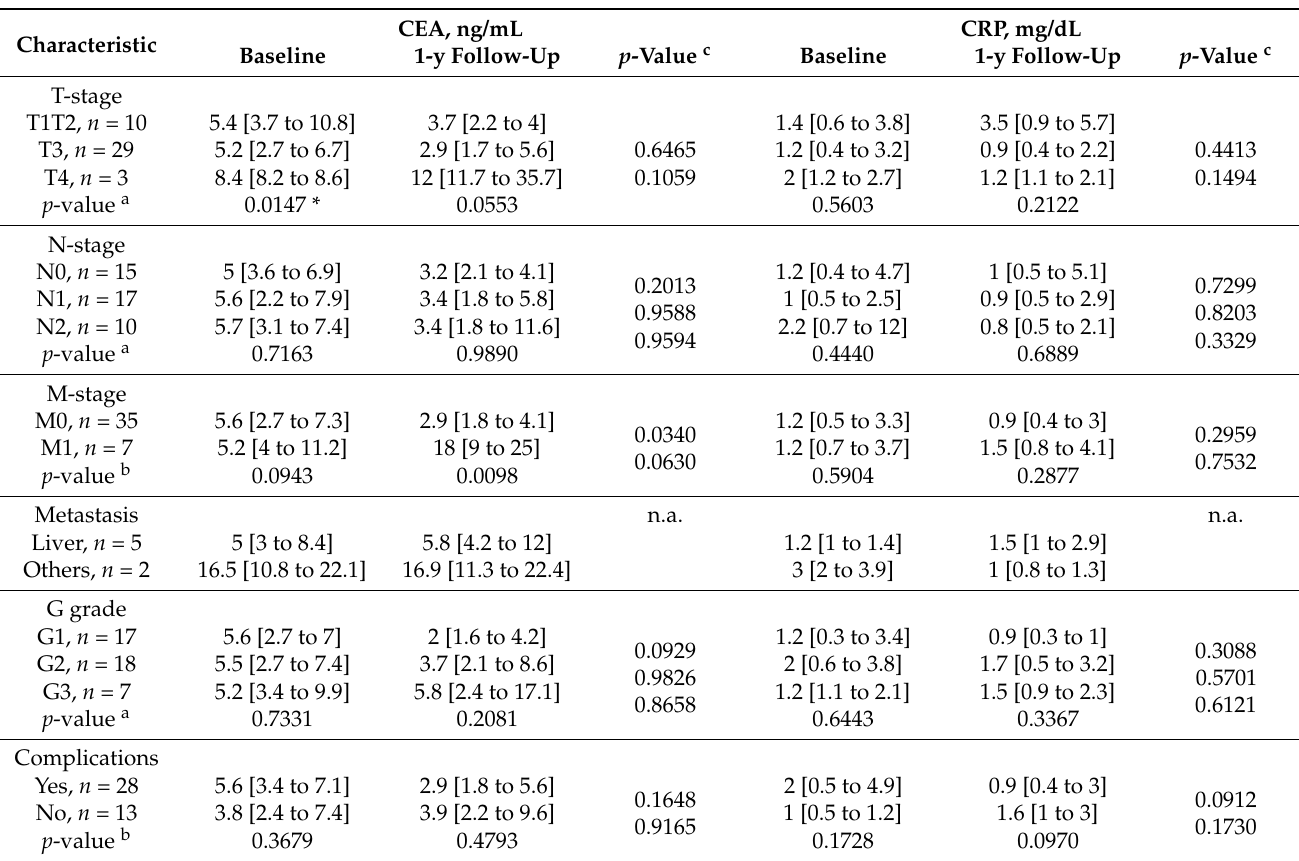
Table 4. Variation of CEA and CRP pre- (baseline) and postoperative (1-year follow-up) and between